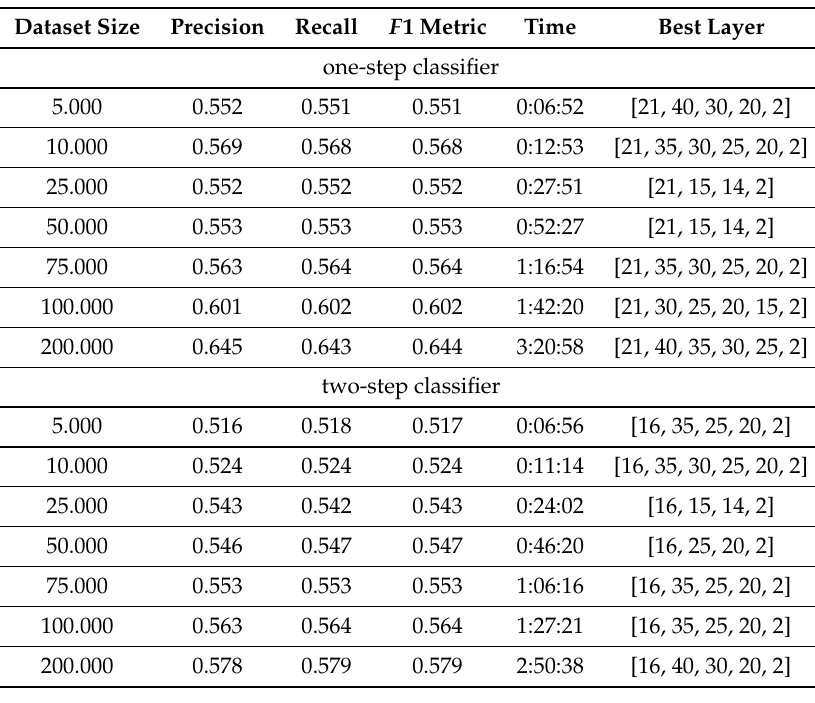
Table 10. Multilayer perceptron.